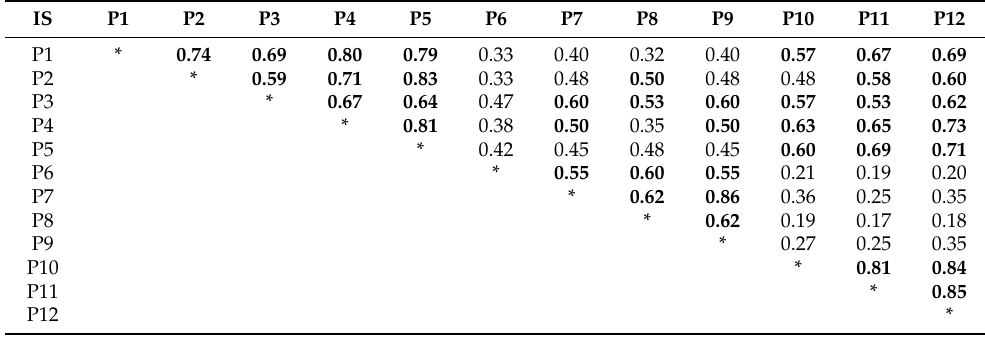
Table 5. Sørensen similarity values (IS) between the mosquito sampling sites at the Centro de Primatolo- gia do Rio de Janeiro. IS P1 P2